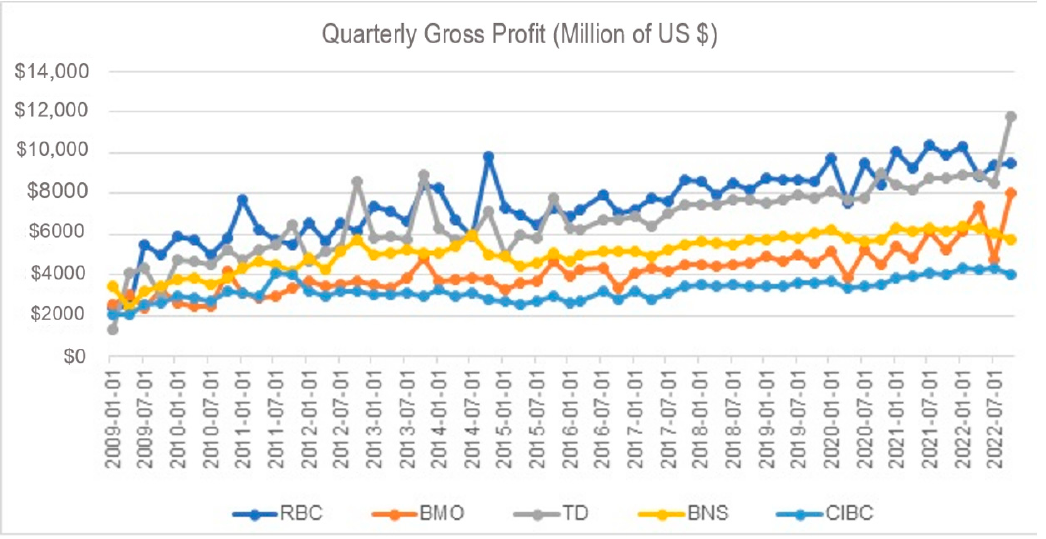
Figure A4. Quarterly gross profit of the five banks (Source: Data 2 n.d. https://www.macrotrends.net/stocks/charts, accessed on 12/12/2022).